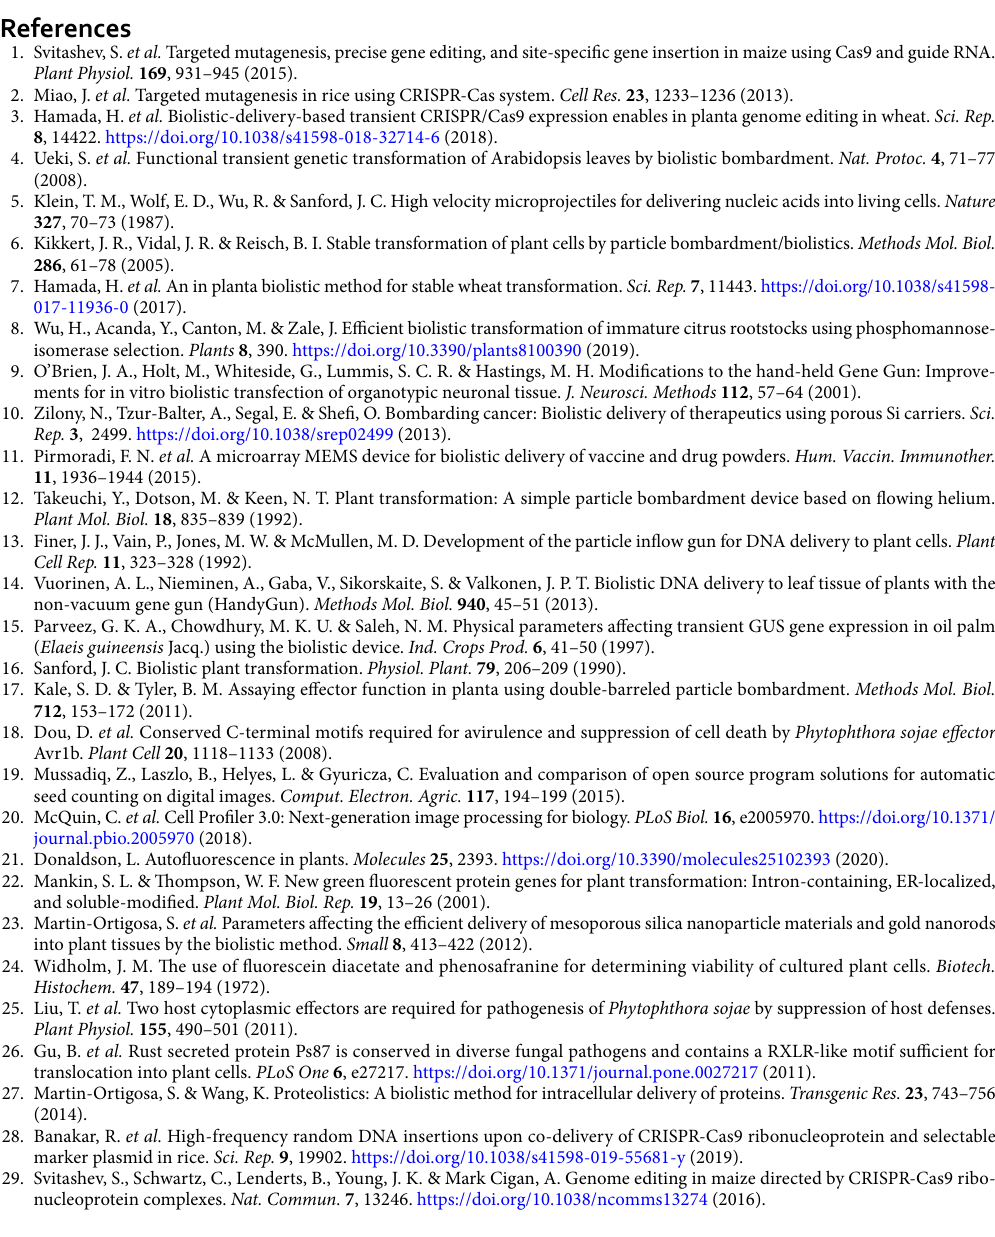
Statistical analysis. The chart generated for Fig. 6M shows two values and standard deviations calculated differently. First, the numbers of red and green cells were counted for each treatment. Then, the green/red cell ratio was calculated for each sample. For the on-target gRNA (+ gRNA), the green/red cell count ratio was divided by that of the positive control (i.e., in-frame construct). The mean and standard deviation were cal- culated from the samples with a sufficient number of cells (> 180 for positive control, and > 90 for the negative control). For the off-target gRNA comparison, no DB experiments were performed with the in-frame control, thus paired sample analysis was not possible. Thus, the mean and standard deviation of the green/red cell ratio were individually calculated for the off-target gRNA and the in-frame control. Finally, the editing efficacy ratio (Q) was calculated by dividing the green/red cell ratio of the off-target gRNA (a) with that of the in-frame control (b). The standard deviation of this editing efficacy was calculated via the error propagation formula for division and multiplication 37 , shown below. The variables δ a and δ b are the respective standard deviations of those